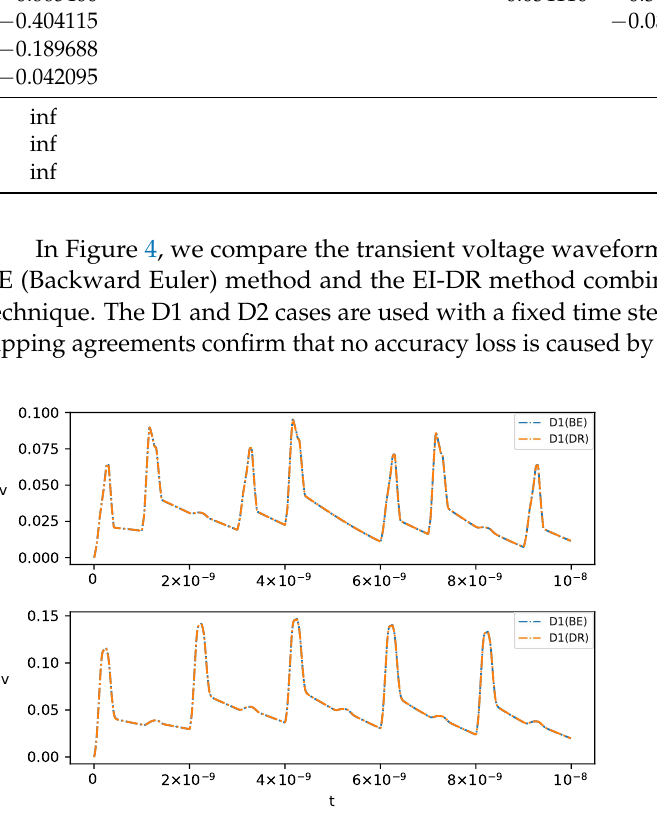
Figure 4. Voltage waveform comparisons between BE and EI-DR for D1 and